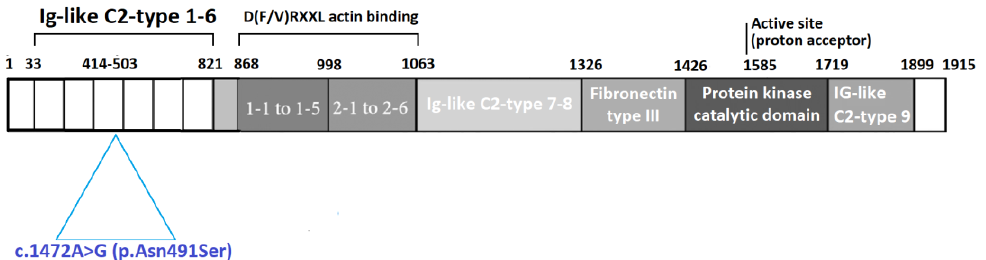
Figure 1. A graphic illustration of the full-length human MYLK gene, structural model consisting of 1915 amino acids with domains; this gene, a muscle member of the immunoglobulin gene superfamily, encodes myosin light chain kinase (a calcium-calmodulin dependent enzyme). Also regulates actin-myosin interaction through a non-kinase activity. Depicted are the actin-binding domain, catalytic core, the regulatory segment containing the inhibitory and calmodulin-binding domains, and the kinase-related protein (KRP) domain. The region where the patient’s variant c.1472A>G (p.Asn491Ser) is located is indicated by the blue triangle. In our case, the MYLK mutation interests the codon 491, localized in the exon 11, in the Ig-like domain 3, involved in the EC cytoskeletal functions based on